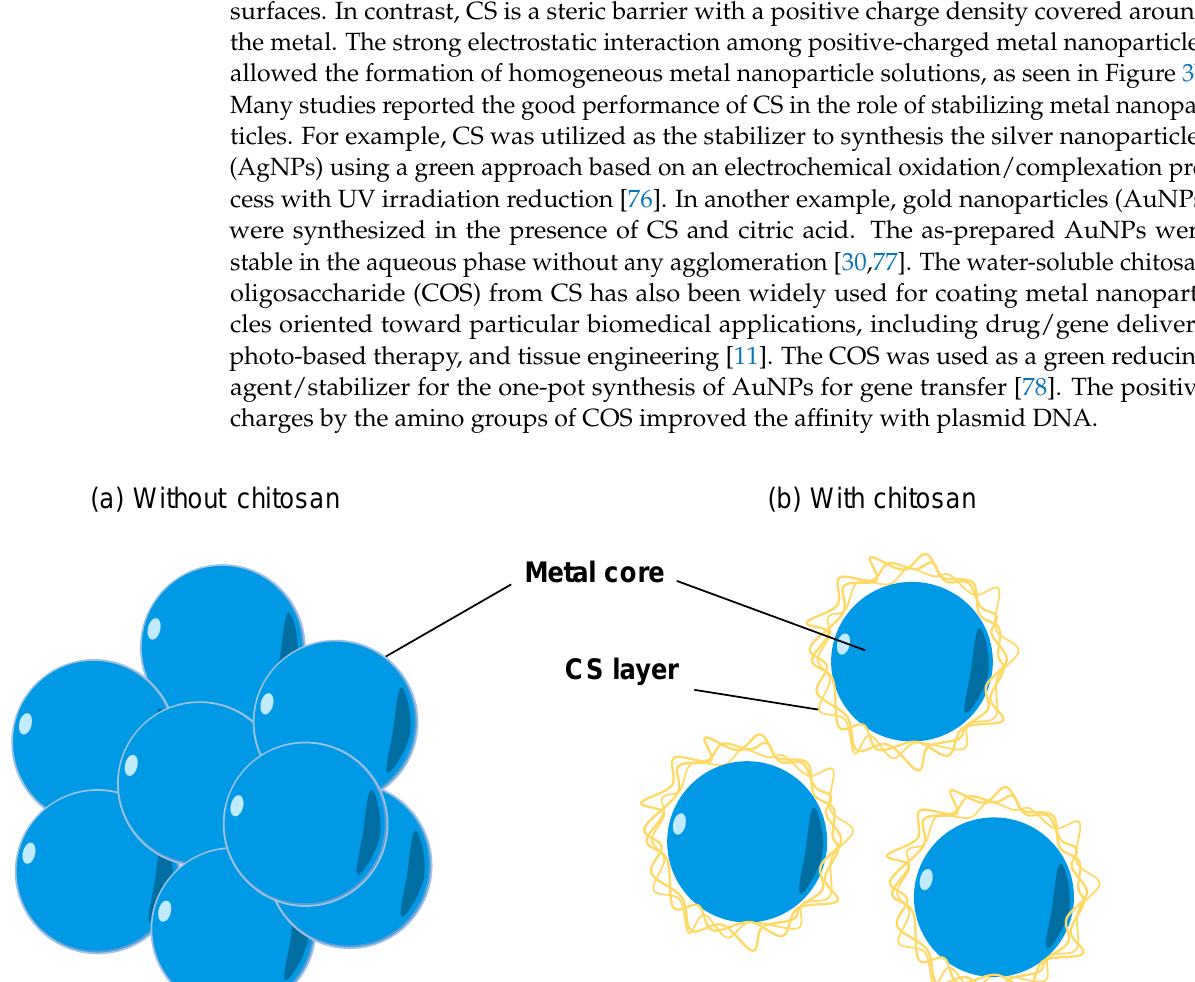
Figure 2. Overview of the role of chitosan in green synthesis of metal nanoparticles.